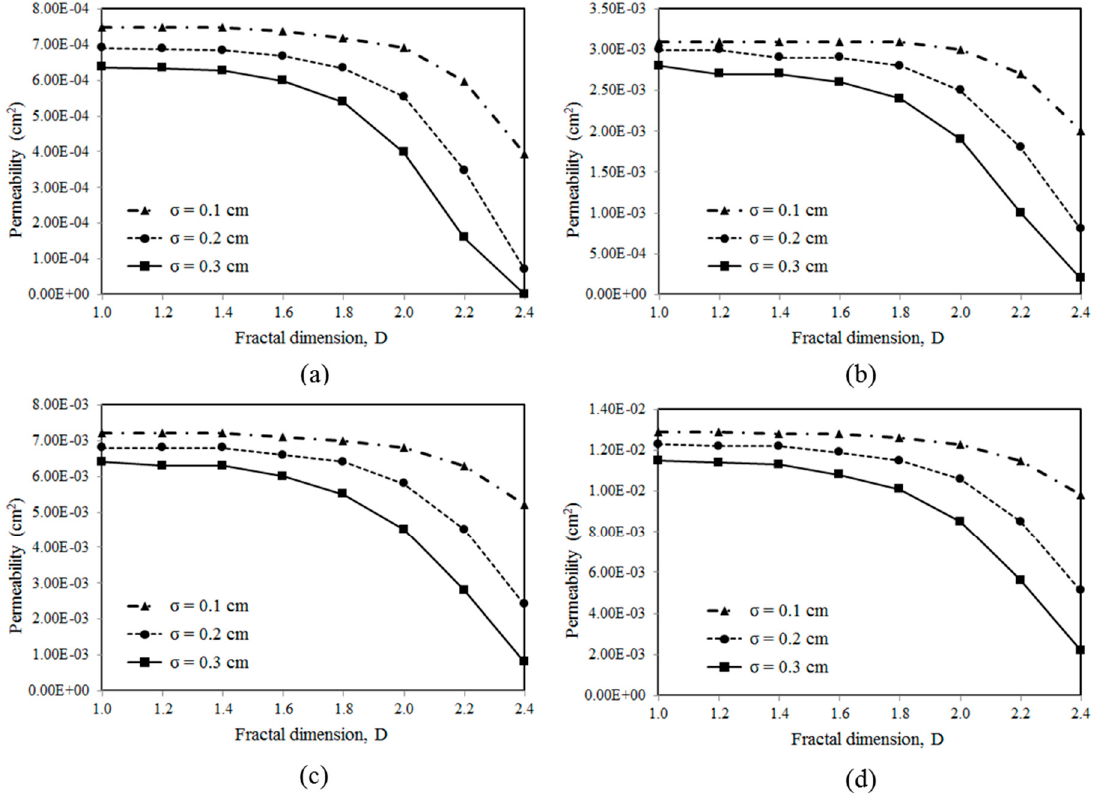
Figure 9. The influence of fractal dimension and standard deviation on the permeability of a single fracture: ( a ) aperture = 0.1 cm; ( b ) aperture = 0.2 cm; ( c ) aperture = 0.3 cm; ( d ) aperture = 0.4 cm.